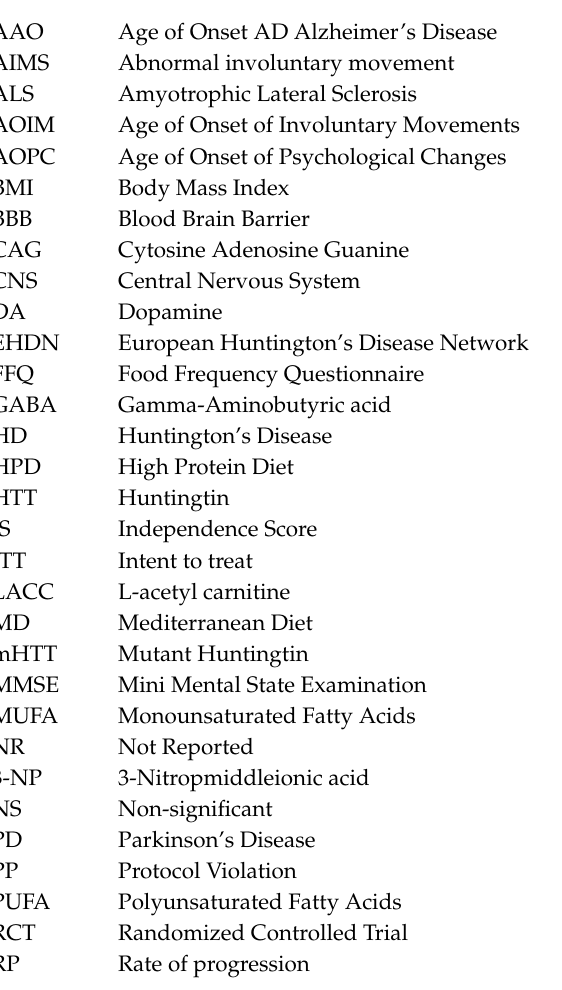
Table S1: PRISMA Checklist, Table S2: Quality assessment of cohort studies using Newcastle-Ottawa, Table S3: Quality assessment of case control studies using Newcastle-Ottawa, Table S4: Quality assessment of randomized trials using Cochrane, Figure S1: Newcastle-Ottawa quality assessment scale case control studies, Figure S2: Newcastle-Ottawa quality assessment scale cohort studies, Figure S3 Cochrane risk of bias tool for randomized controlled trials. Supplementary information S1: Study